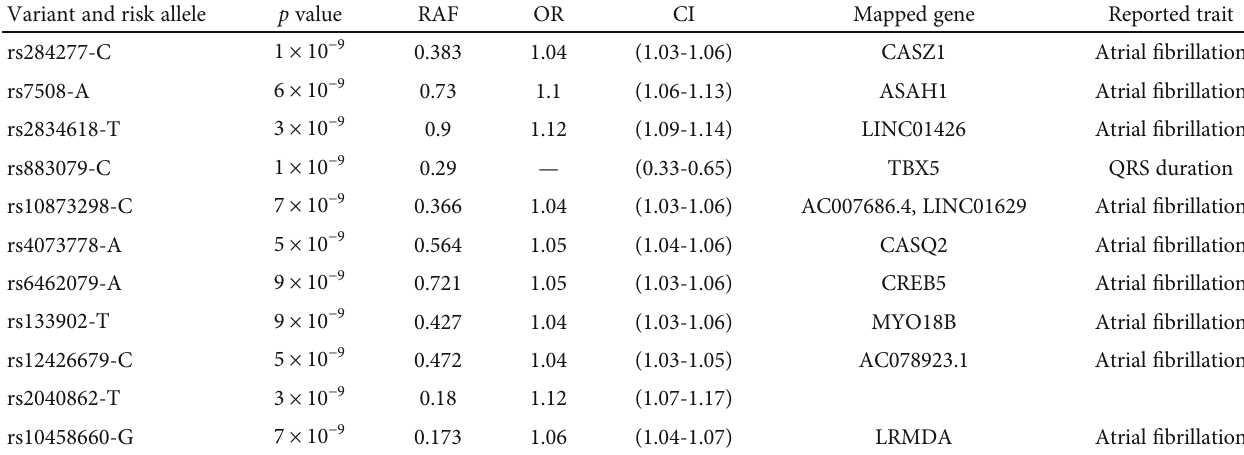
Table 6: Published data from the GWAS catalogue of relevant SNPs associated with AF in PRH. Variant and risk